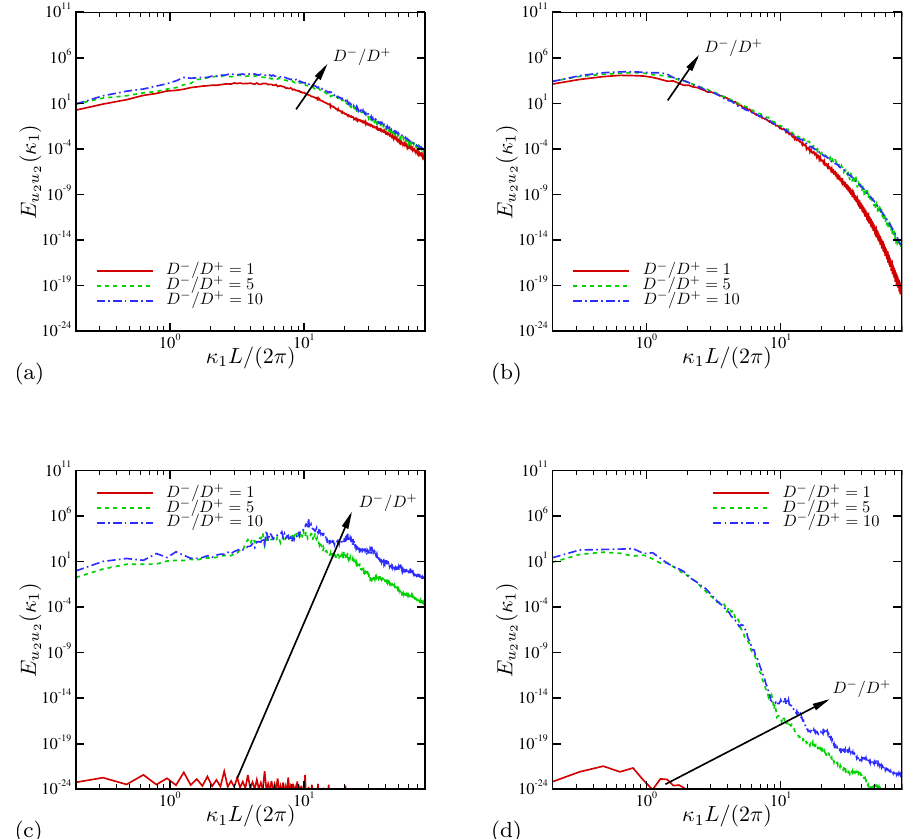
Figure 28. Spatial power spectral density of wall-normal velocity: ( a ) ω 0 / ( 2 π ) = 20 and x 2 / L = 0.03; ( b ) ω 0 / ( 2 π ) = 20 and x 2 / L = 0.5; ( c ) ω 0 / ( 2 π ) = 1000 and x 2 / L = 0.03; ( d ) ω 0 / ( 2 π ) = 1000 and x 2 / L =